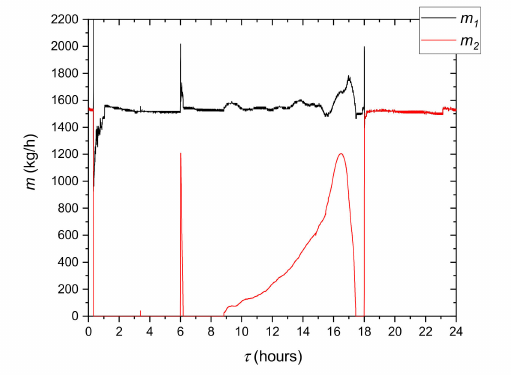
Figure 21. Variation over time of the overall HTF flow rate m 1 and flow rate through the LHTES m 2 during the third